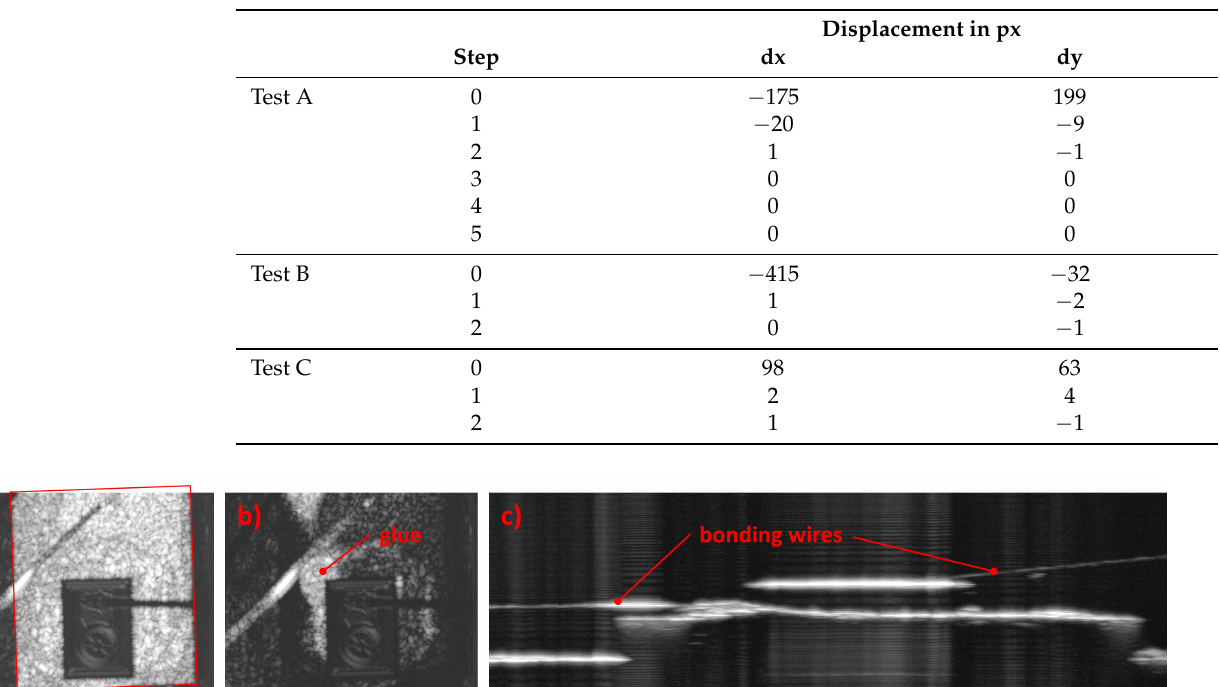
Table 2. Results of displacement correction trials. In test A, five measuring and correction steps were performed to prove that the mechanism was stable. All three tests show that after a maximum of two correction steps, the displacement was reduced to less than 1 micrometer.